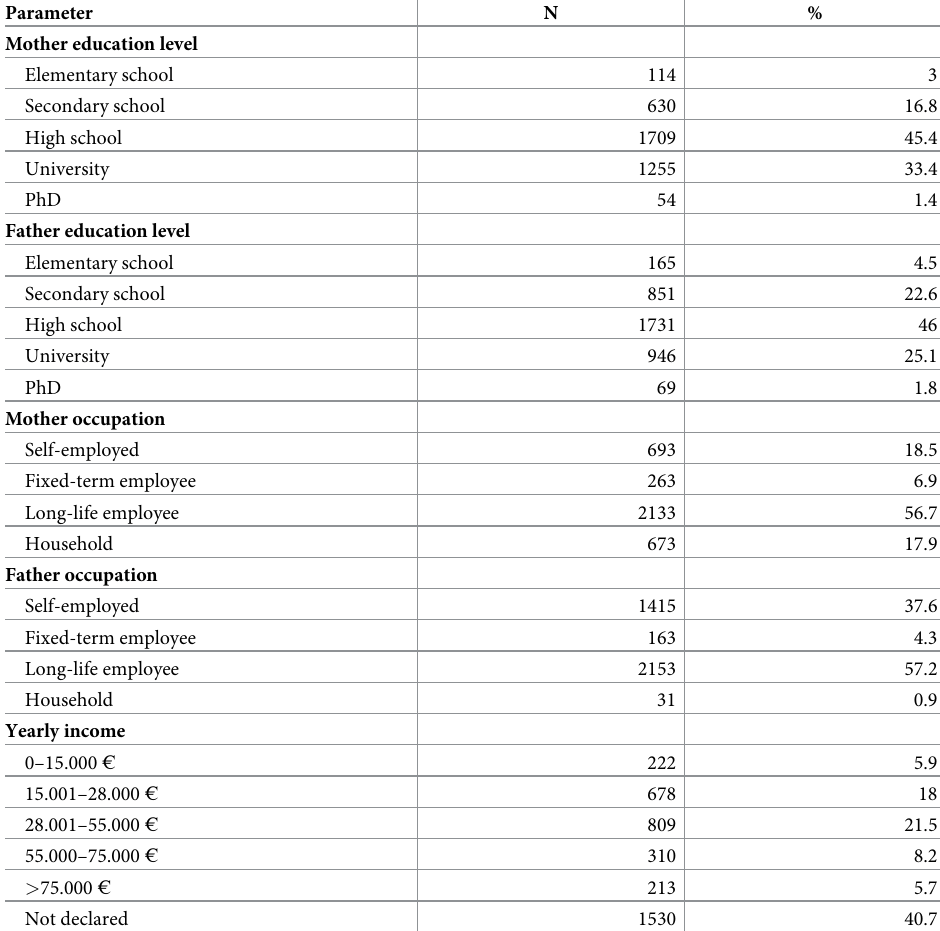
Table 2. Family of origin